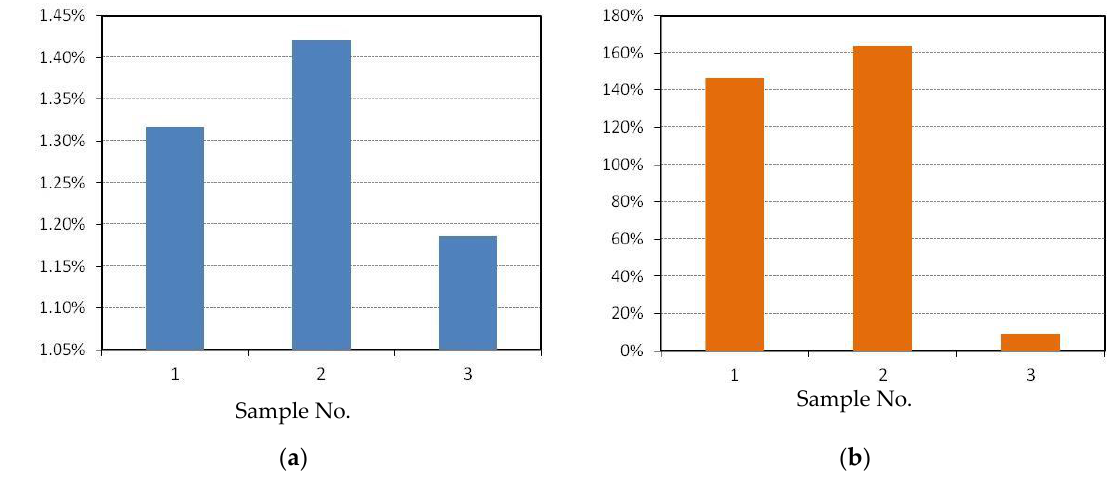
Figure 6. Deviations of the thermodynamic criteria of consolidation from the ideal value: ( a ) K 1 , ( b ) K 2 .